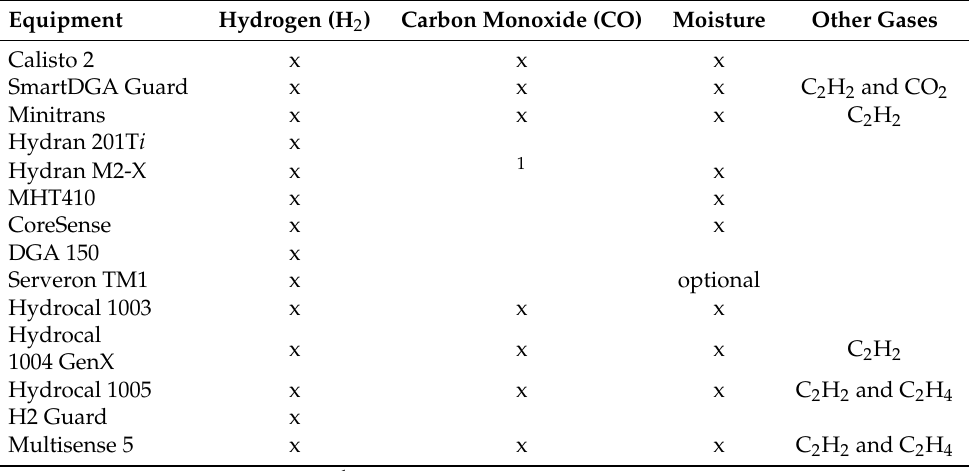
Table 6. Parameters measured by fault detection monitors (as indicated by manufacturers).